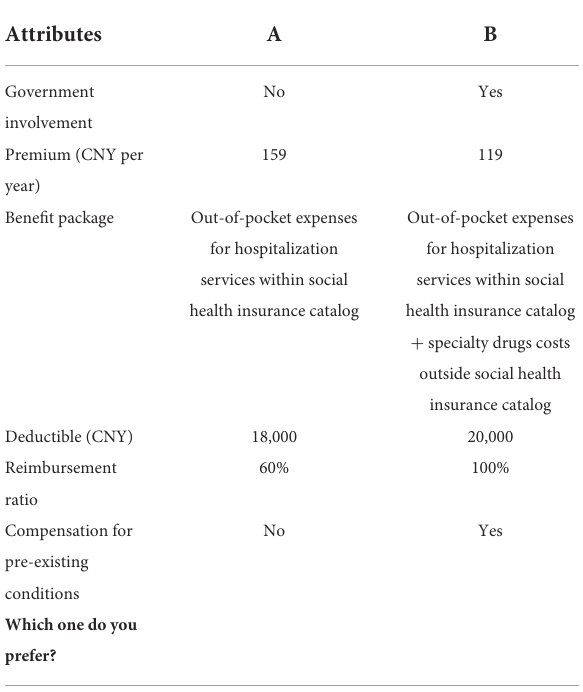
TABLE 2 Example of choice set. TABLE 3 Participants’